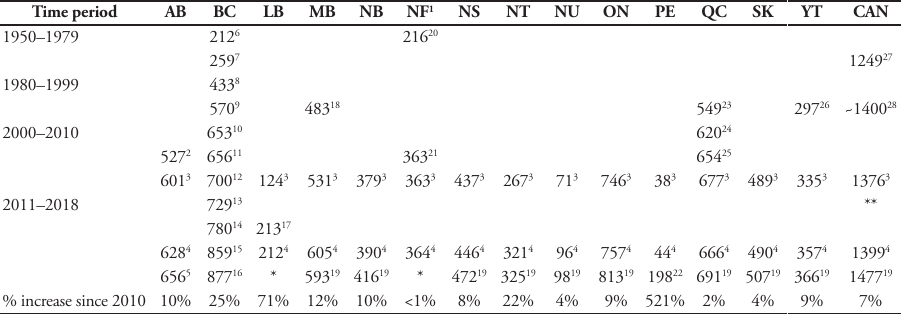
Table 3. Changes in Canadian national, provincial, and territorial spider species numbers over time and percent increase since